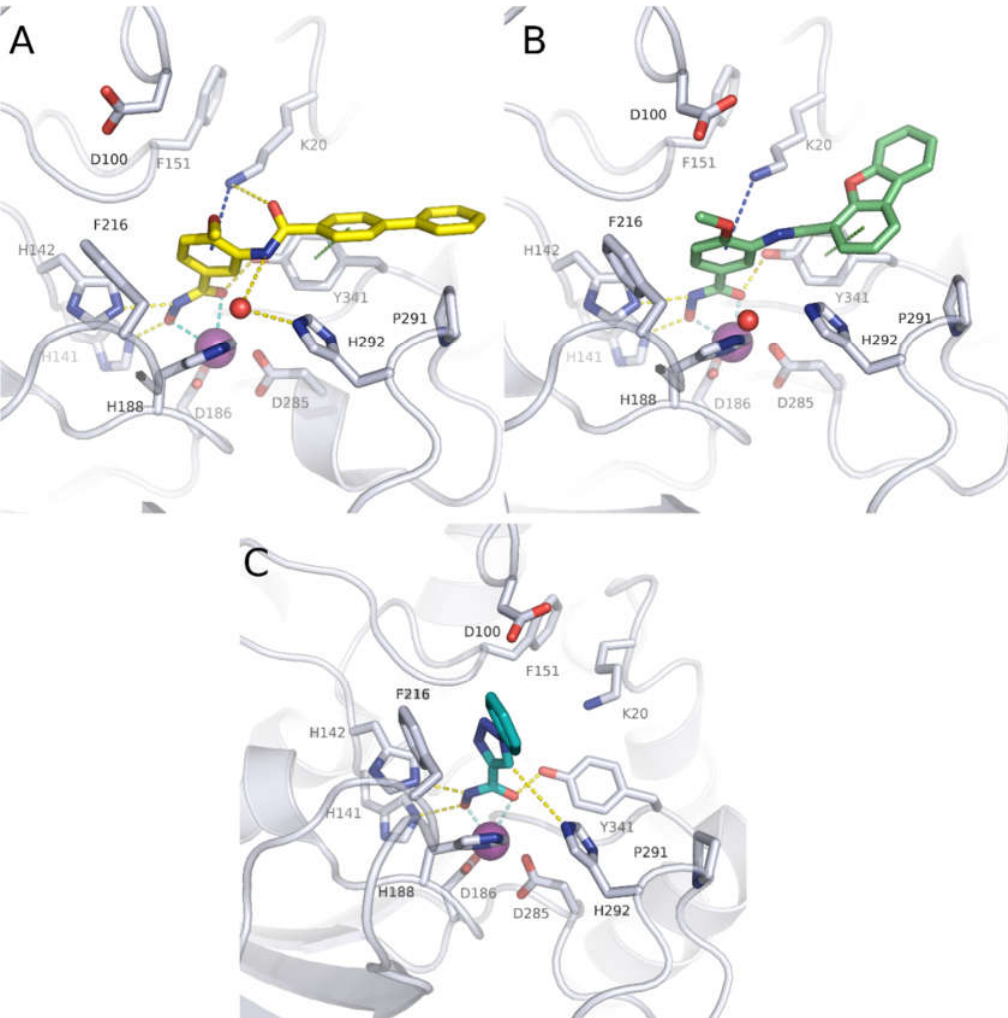
Figure 2. Crystal structures of some smHAC8 inhibitors. ( A ) Crystal structure of smHDAC8 with compound 6 shown as yellow sticks (PDB ID 5HTH); ( B ) crystal structure of smHDAC8 with compound 8 shown as green sticks (PDB ID 7P3S); ( C ) crystal structure of smHDAC8 with compound 12 shown as teal sticks (PDB ID 6TLD). The catalytic zinc ion is shown as purple sphere and water molecules as red spheres. Cyan-dashed lines indicate metal coordination, yellow-dashed line hydrogen bond interactions, green-dashed lines π-π interactions, and blue-dashed line cation-π interactions.